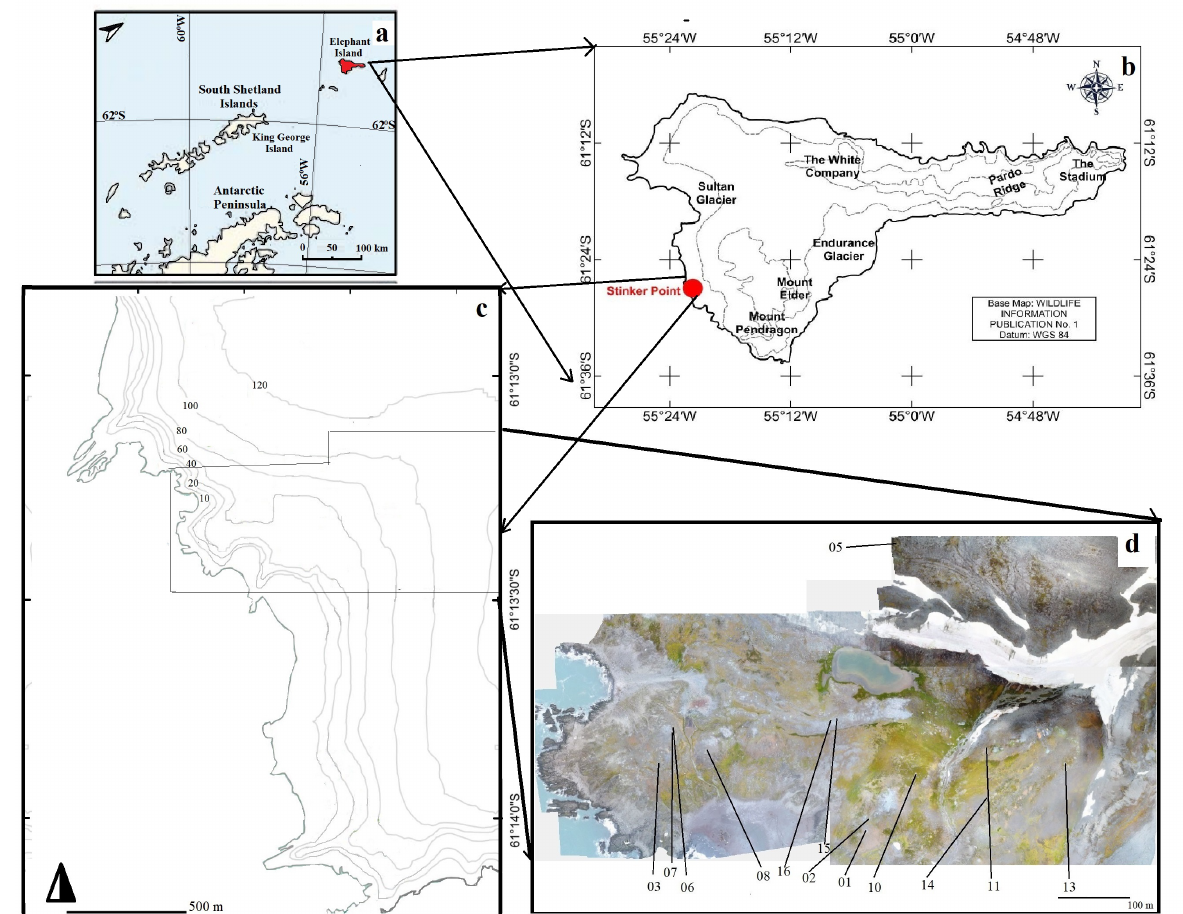
Figure 1. Schematic map of the South Shetland Islands (a), Elephant Island (b), Stinker Point (c), and the area studied